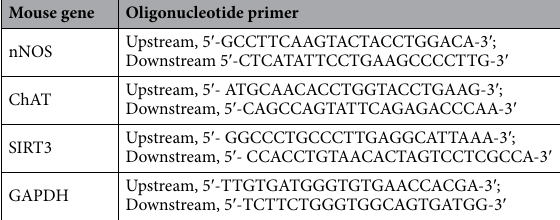
Mouse gene Oligonucleotide